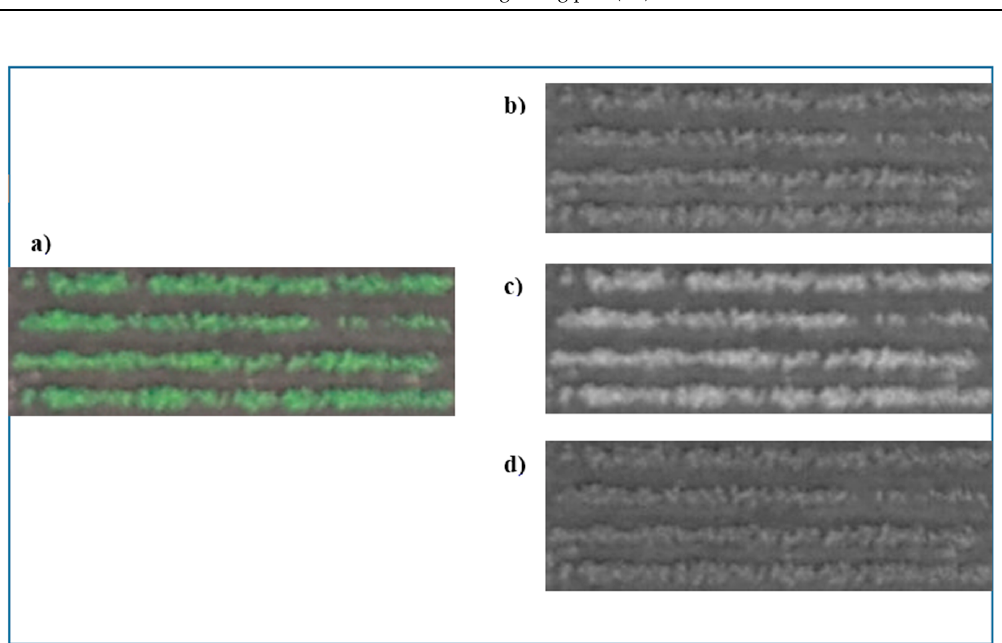
Figure 2. Example of the plot image in the RGB (containing three channels: RED, GREEN, and BLUE) color space ( a ) and individual channels of the same plot: R ( b ), G ( c ), and B ( d ) after separation of the RGB image in Fiji.